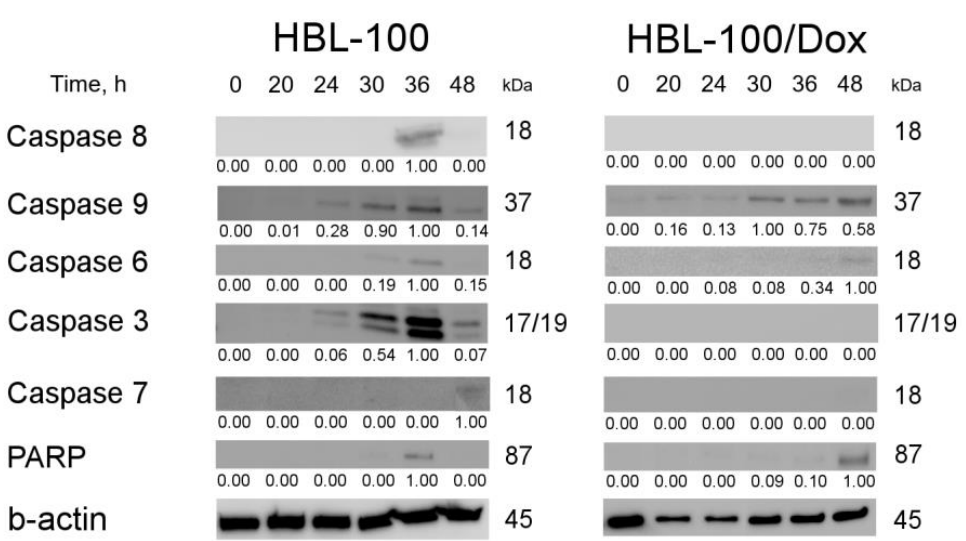
Figure 10. Western blot analysis of the expression of caspases-3,-6,-7,-8, and -9 and PARP in HBL-100 and HBL-100/Dox cells after OA -treatment for 20, 24, 30, 36 and 48 h. β -Actin was used as loading control.